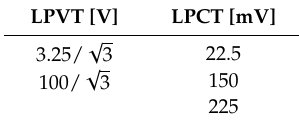
Table 1. Rated outputs, taken from IEC 61869-10 and -11, for LPCTs and LPVTs,